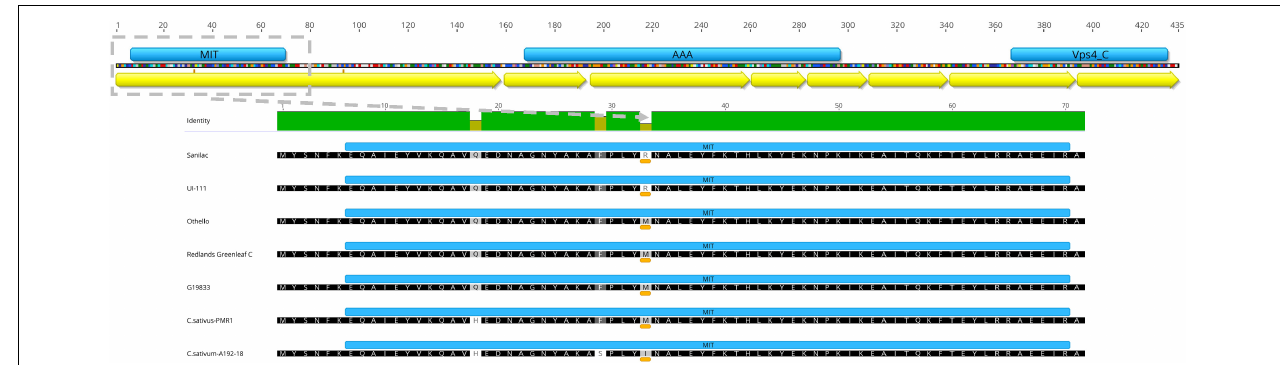
FIGURE 4 | Phvul.005G125100 candidate gene for bc-4 . (Top) Phvul.005G125100 shows three domains (blue bars) and eight exons (yellow arrows). (Bottom) Microtubule interacting and transport (MIT) domain (blue bar) zoomed in for five Phaseolus vulgaris lines and two Cucumis sativus lines (Amano et al., 2013), depicting the amino acid substitution for position 33 underlined by an orange-colored